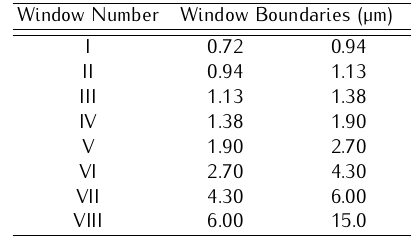
Table 1. Types of atmospheric scattering. Table 2. Wavelength regions of Earth’s atmospheric